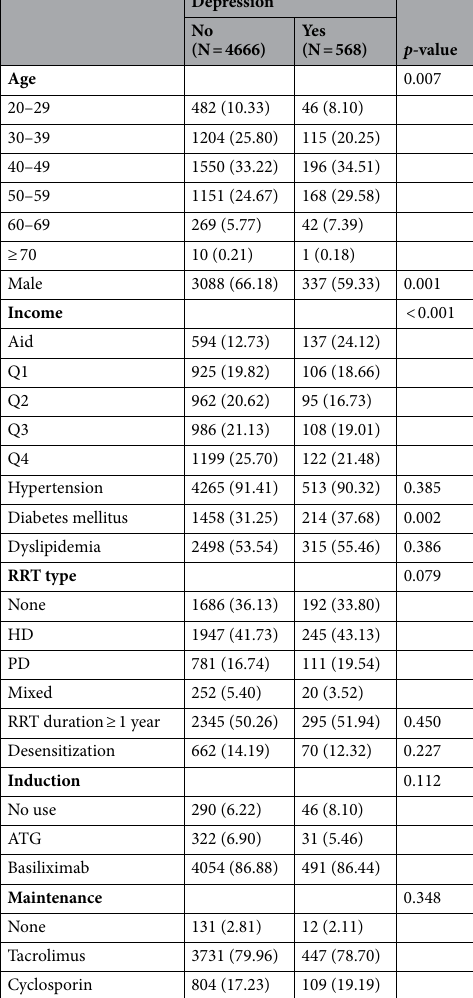
Table 4. Clinical characteristics according to the presence of incident depression in KT group. Data are presented as the mean ± standard deviation, or n (%). KT kidney transplant, CCI Charlson Comorbidity Index, RRT renal replacement therapy, HD hemodialysis, PD peritoneal dialysis, ATG antithymocyte globulin